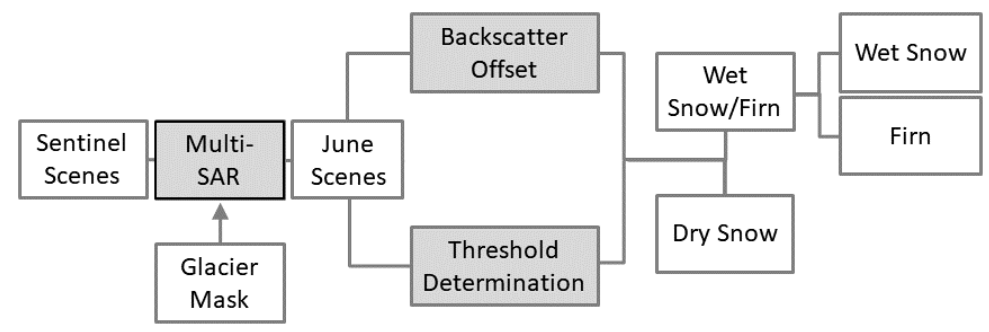
Figure 2. Workflow for the classification of wet and dry snow and firn based on Sentinel-1 data. Grey shaded boxes indicate data processing.